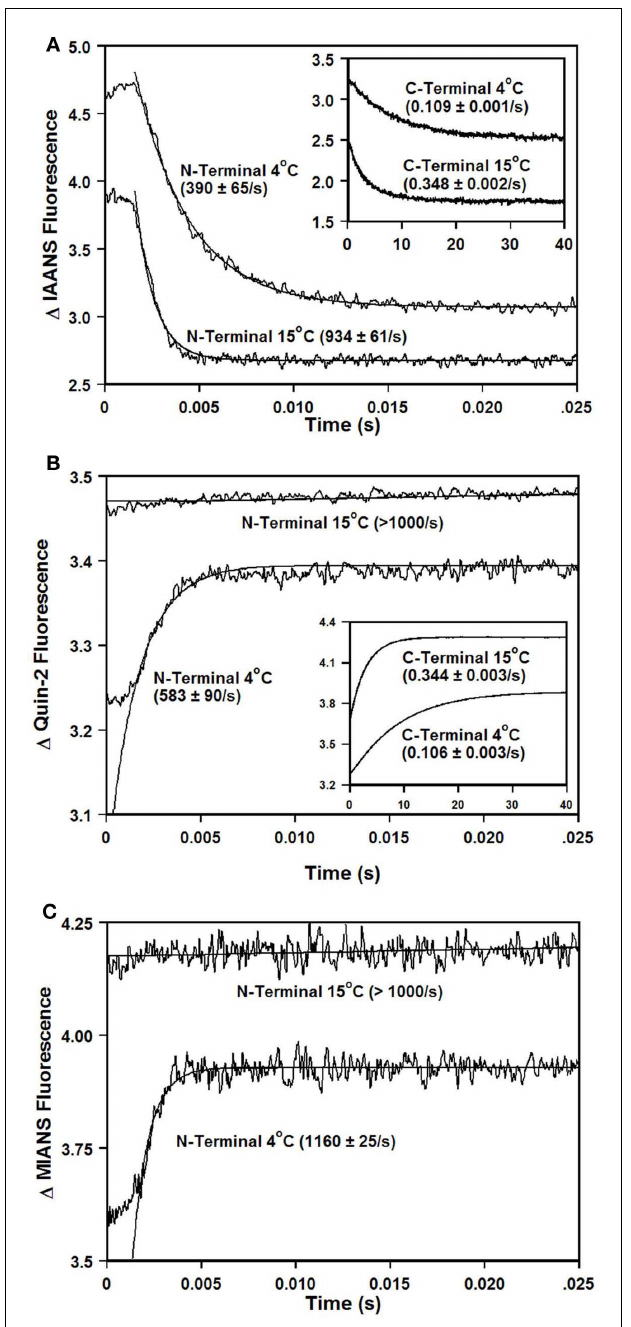
FIGURE 4 | Comparison of calcium dissociation kinetics from isolated TnC T54C,C101S TnC T54C,C101S , andTnC T54C,C101S . (A) Shows the time course of IAANS , MIANS decrease in IAANS fluorescence as Ca 2 + was removed by EGTA from the N-terminal regulatory and C-terminal structural [ (A) inset] Ca 2 + -binding sites ofTnC T54C,C101S .TnC T54C,C101S IAANS